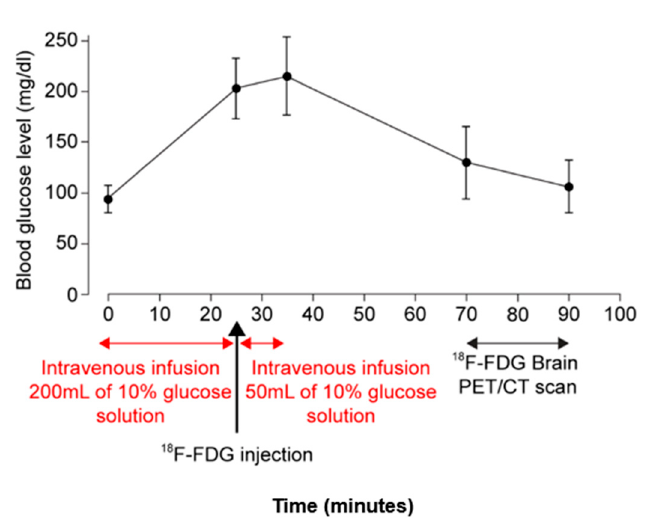
Figure 3. Blood glucose level by intravenous infusion of 10% glucose solution.